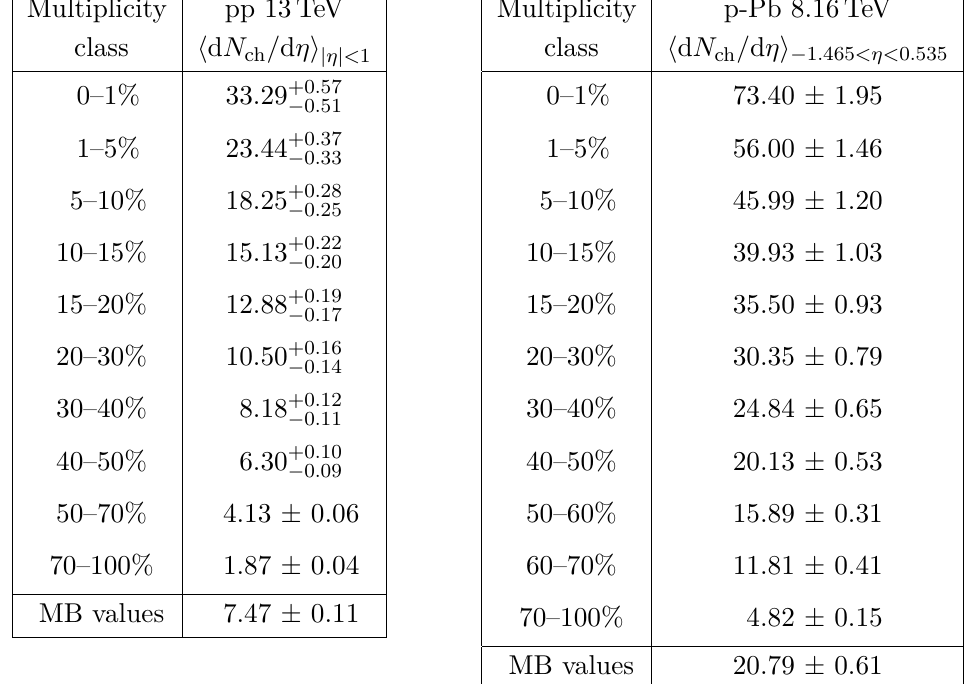
Table 2 . Charged-particle multiplicity classes based on the SPD tracklet estimator and corresponding h d N ch / d η i values in 2 units of pseudorapidity around midrapidity, | η | < 1 in pp collisions at 13 TeV [19] and − 1 . 465 < η < 0 . 535 in p-Pb collisions at 8.16 TeV [20]). The MB values for the two colliding systems are given in the bottom